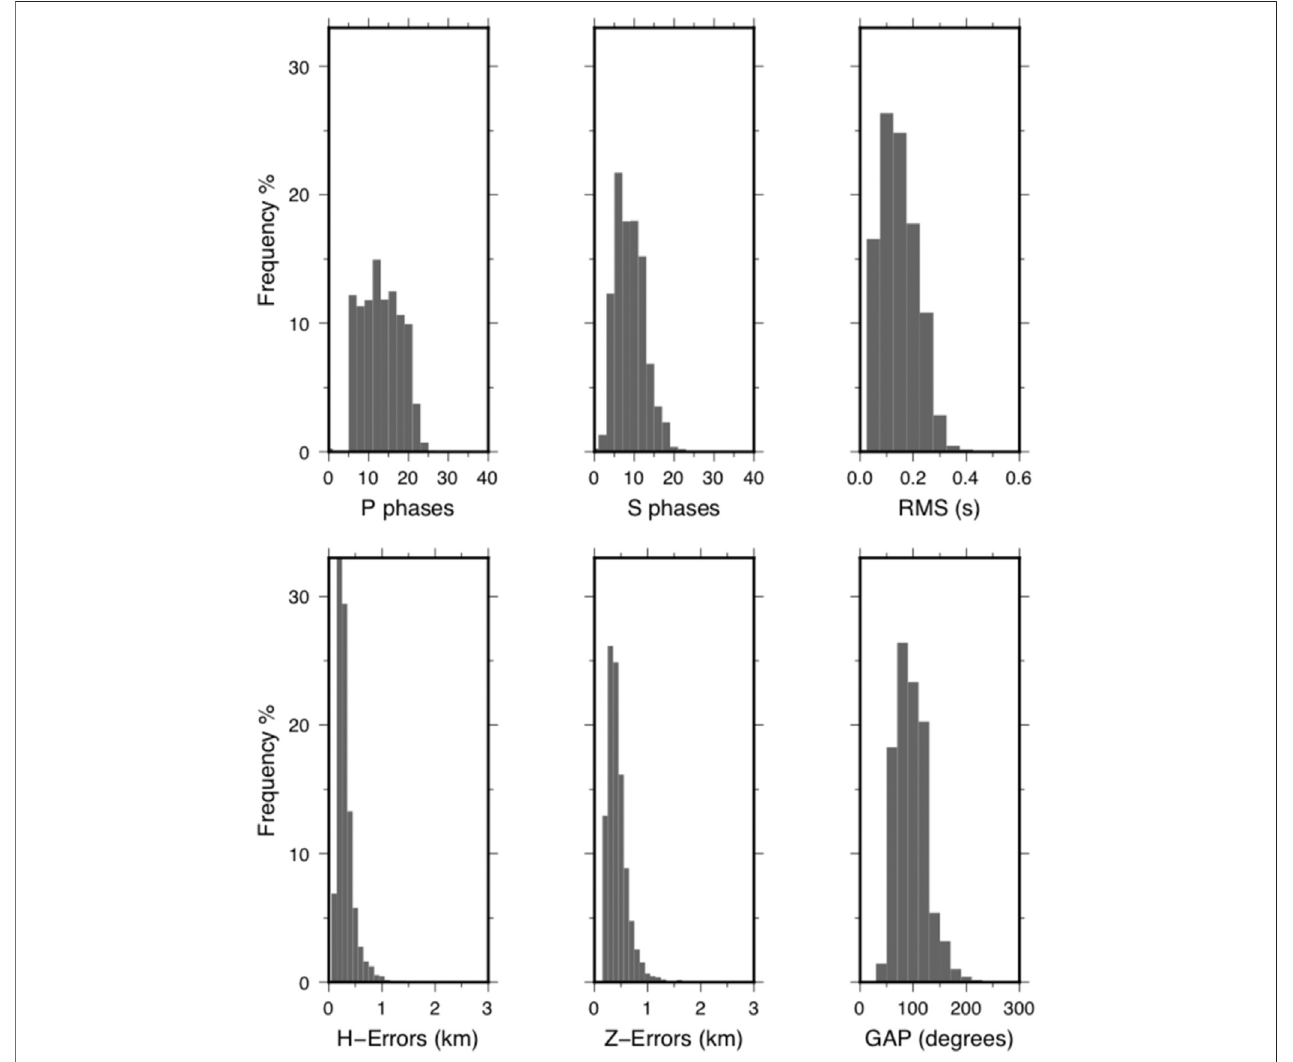
FIGURE 6 | Histograms summarizing the main outputs of the localization procedure, in terms of frequency of observations for each of the following parameters (fromtoplefttobottomright):numberofobservationsforPphases;numberofobservationsforSphases;residualrms(s);horizontallocationerrors(km);verticallocation errors (km); azimuthal gap between stations ( °